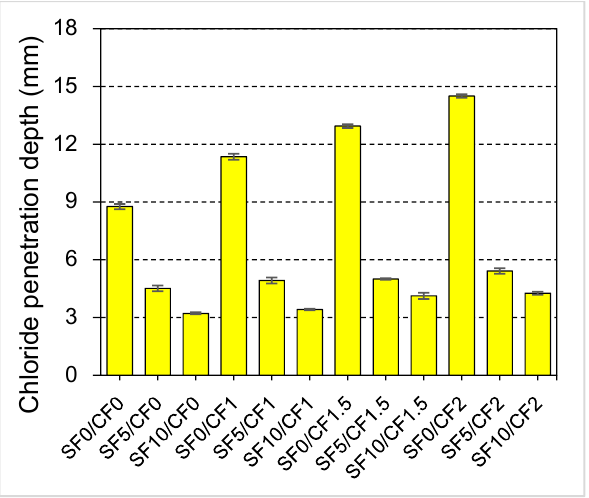
Figure 16. Effect of silica fume and coir reinforcement on the chloride ion penetration of HSC.